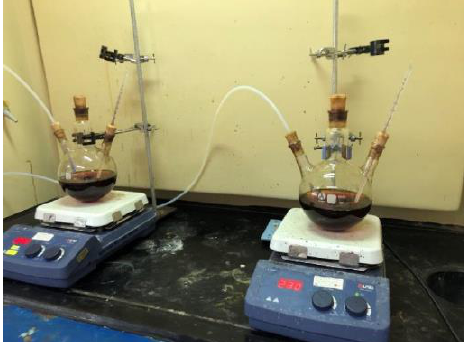
Figure 1. The experimental setup for synthesis of bare iron oxide nanoparticles.